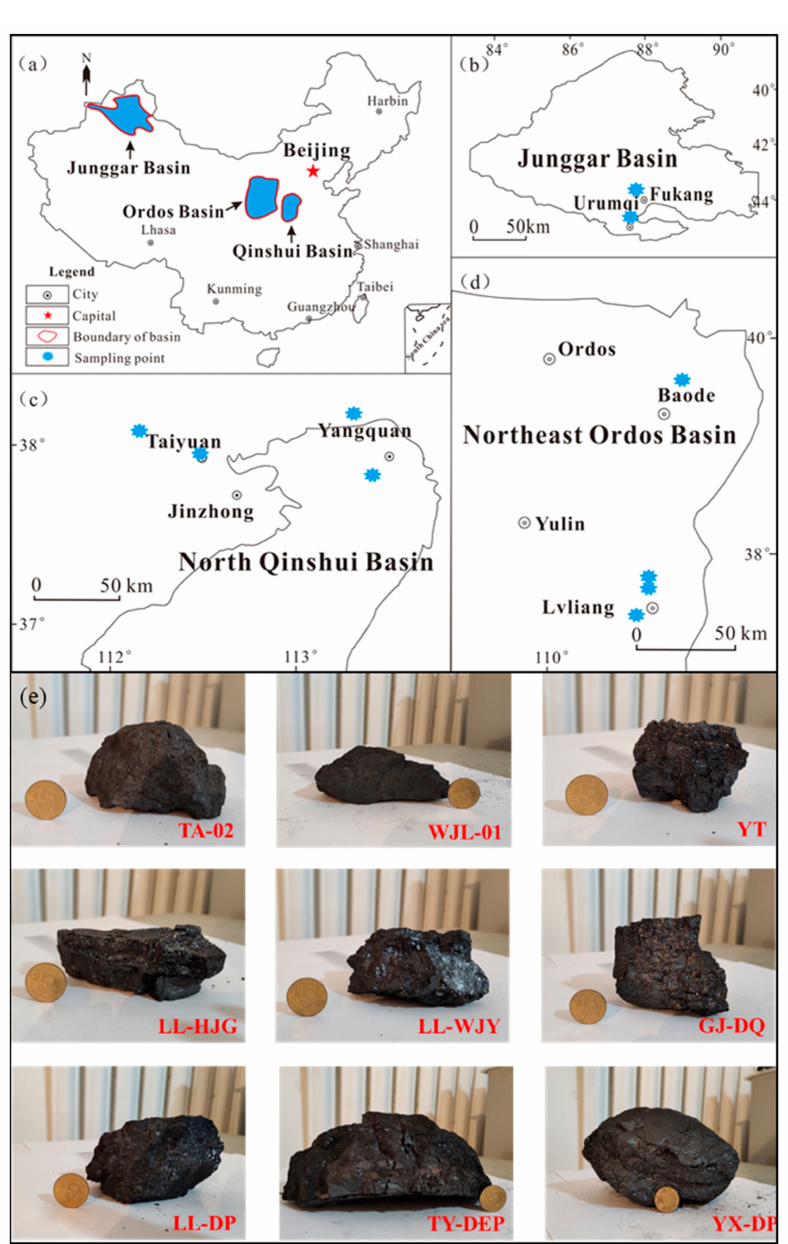
Figure 1. Positions of the Qinshui, Ordos and Junggar basins in China and the distribution of the sampling locations and part of samples for adsorption experiment. ( a ) Locations of Qinshui, Ordos and Junggar Basins in the China Map; ( b ) Sampling points of Junggar Basins; ( c ) Sampling points of North Qinshui Basins; ( d ); Sampling points of Northeast Ordos Basins ( e ) Part of selected